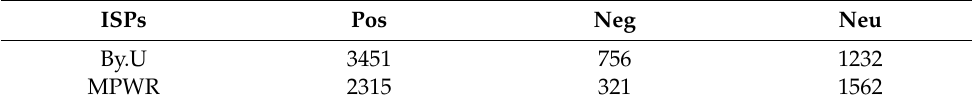
Table 4. The result of manual annotation as ground truth.